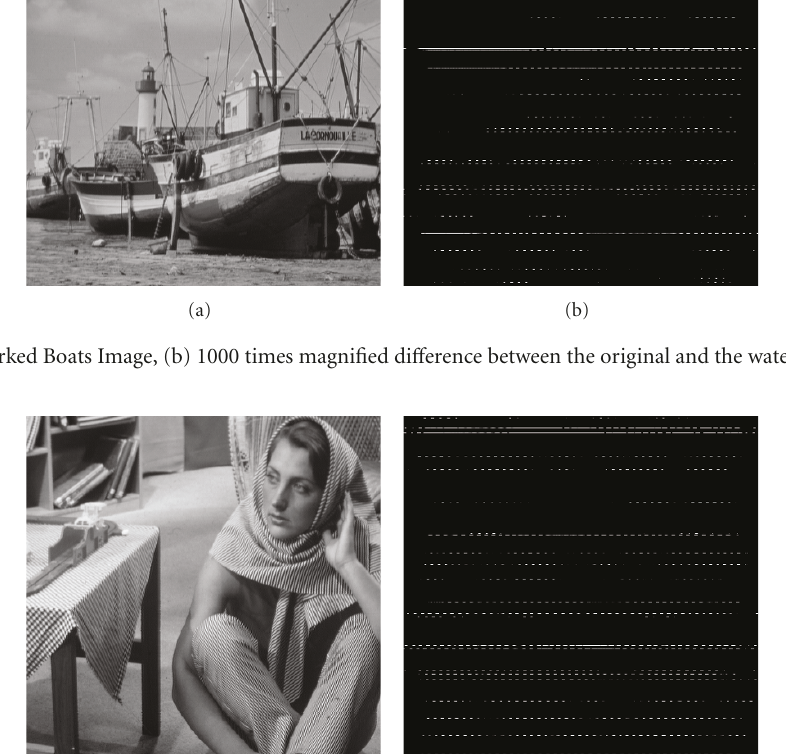
the DET of the original image’s same row is calculated and c ( n ) sequence is obtained